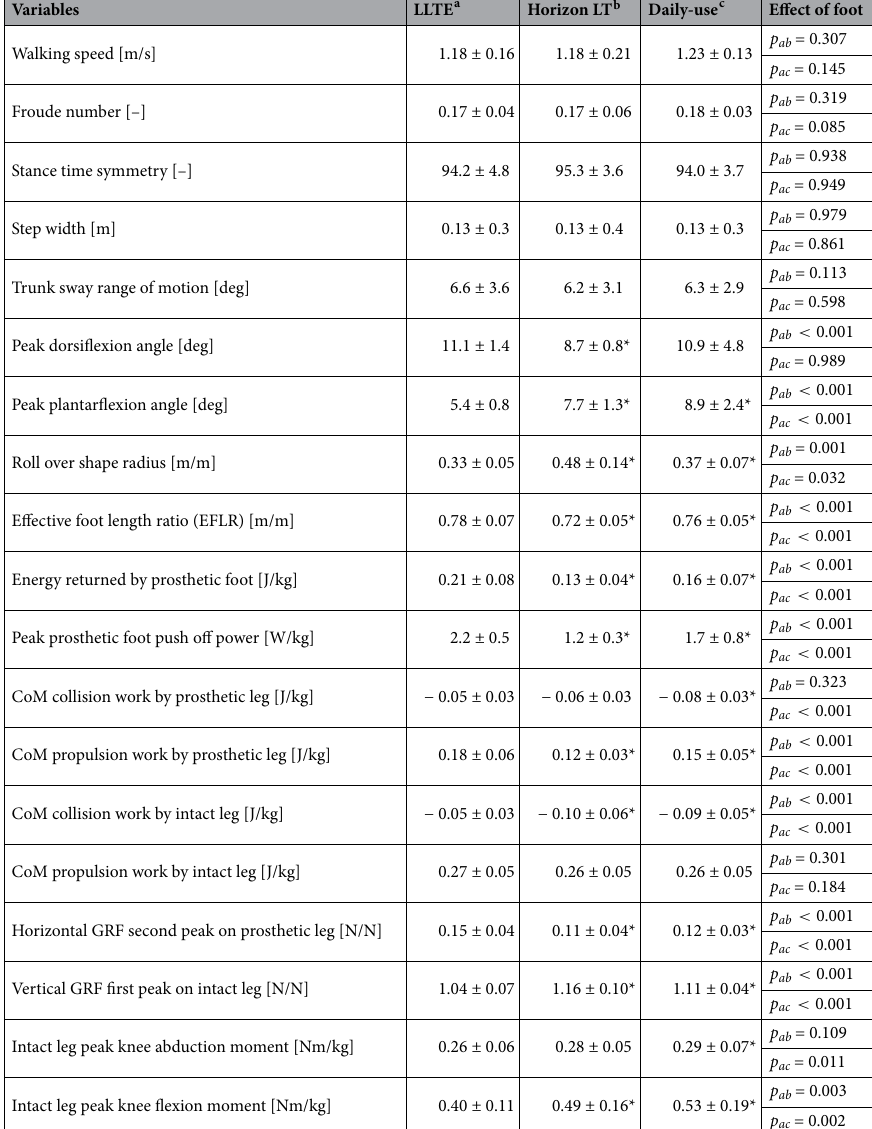
Table 2. Main results and gait parameters for the LLTE feet (labeled a), College Park Horizon LT feet (labeled b) and the participant’s daily-use feet (labeled c) while walking over-ground at self-selected speed. Values shown here are averaged across all the participants. p values between two prosthetic foot condition are shown in the table with the subscript referring to the foot condition’s label. Significant differences to the LLTE feet are denoted by an asterisk